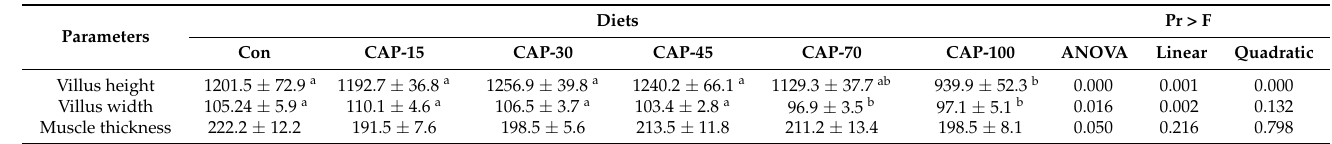
Table 8. Effects of dietary Clostridium autoethanogenum protein on intestinal structure of largemouth bass (µm).